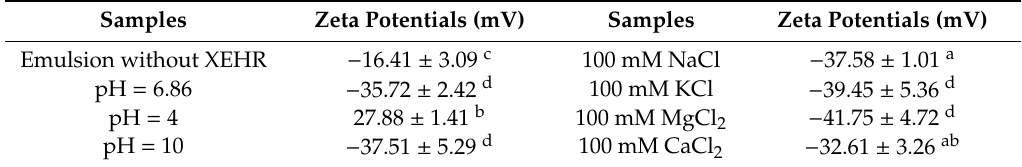
Figure 7. The microstructures of emulsions ( a ) without the XEHR, and at pH of ( b ) 6.86, ( c ) 4, and ( d ) 10, and with ( e ) 100 mM NaCl, ( f ) 100 mM KCl, ( g ) 100 mM MgCl 2 , and ( h ) 100 mM CaCl 2 . The scale bars indicate 100 µ m. Table 5. Zeta potentials of emulsion samples under di ff erent